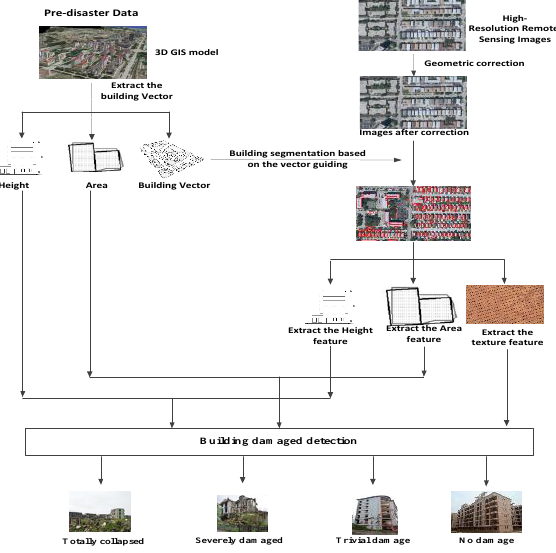
Fig.1. Framework of the proposed